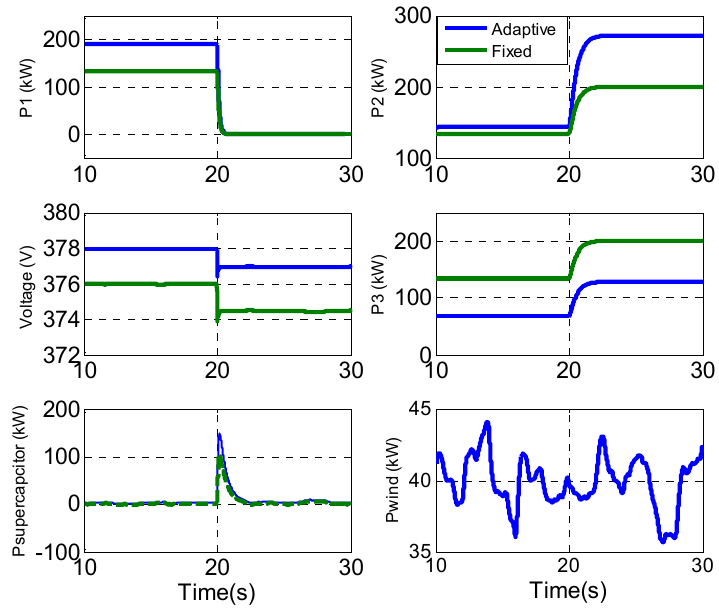
Figure 14. Transients of the system when an outage of BESS 1 happens.